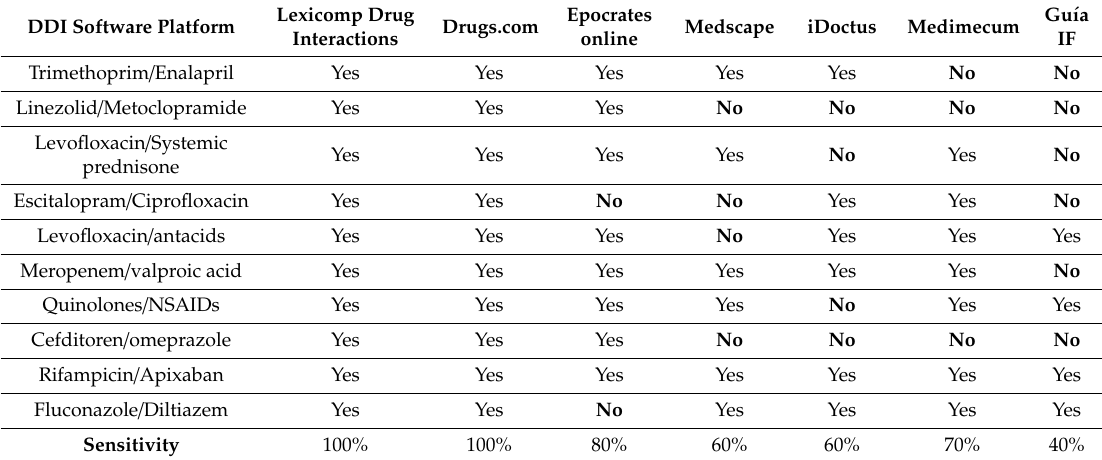
Table 3. Ability of drug–drug interactions (DDIs) software platforms to detect antimicrobial-drug interactions (ADIs).